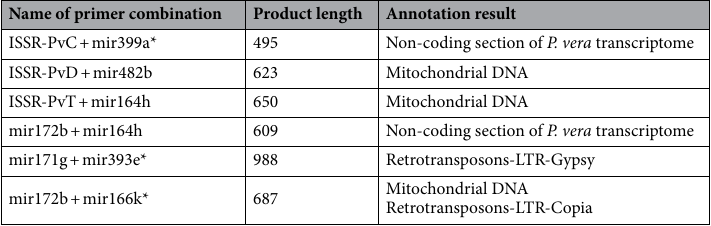
Table 2. The list of six cloned and sequenced bands of miRNA-based markers, their product length and annotation results. *Selected miRNA-based